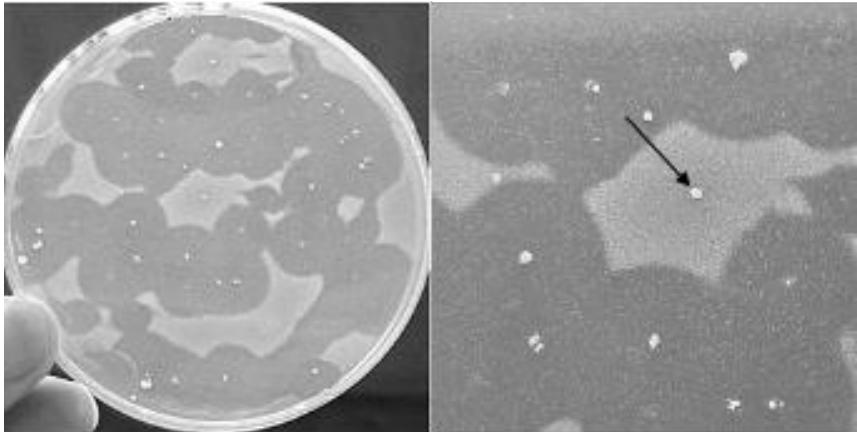
Figure 3. Bac- derivatives of Bifidobacterium thermophilum B23, indicated by arrows, were visually differentiated by deferred antagonism method according to the presence or absence of a distinct inhibition of the indicator lawn.